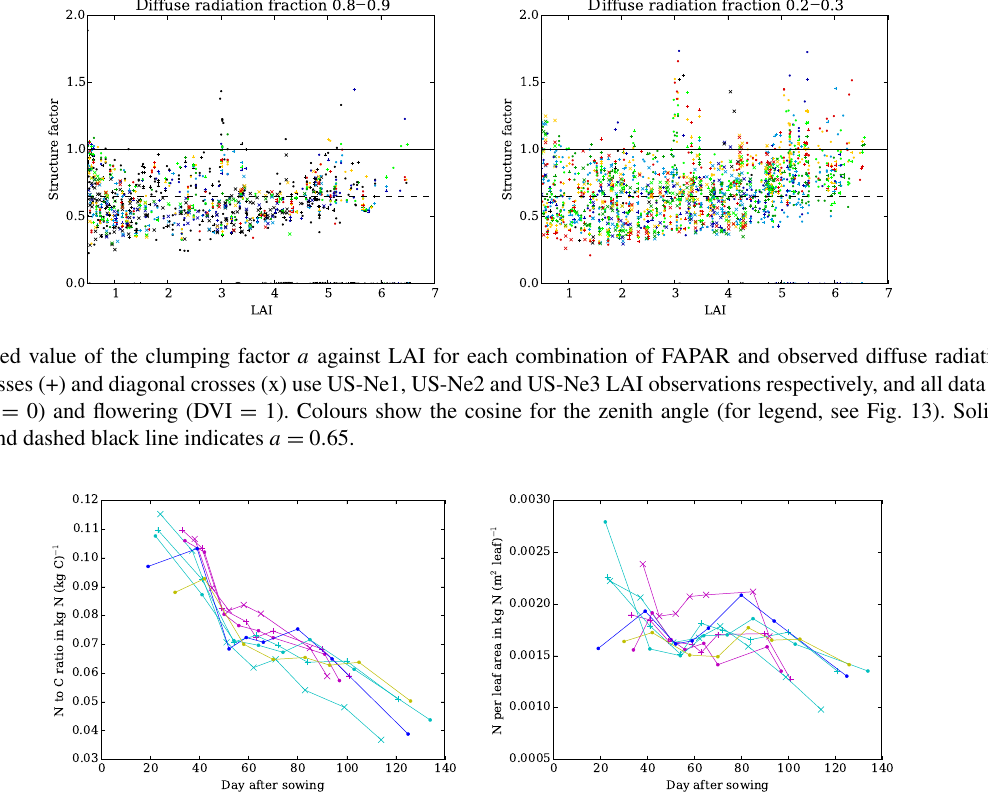
Figure 15. Observed ratio of nitrogen mass to carbon mass in leaves (left) and leaf nitrogen per leaf area (right) against day after sowing. Dots, vertical crosses (+) and diagonal crosses (x) are US-Ne1, US-Ne2 and US-Ne3 respectively. The years 2001–2004 are magenta, blue, cyan and yellow. k nl = 0; i.e. leaf properties are assumed constant through the canopy.